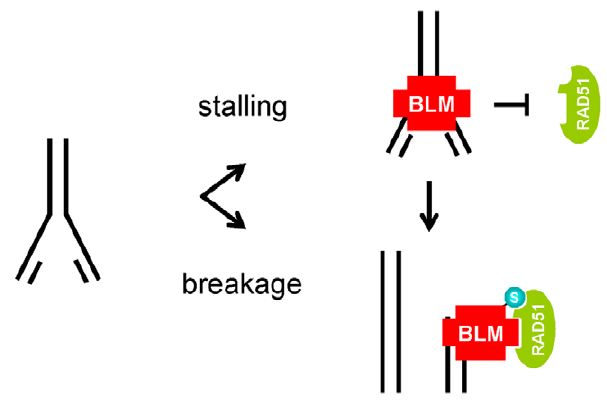
Figure 7. BLM SUMOylation regulates BLM and RAD51 function in HR-mediated repair of damaged forks. The model depicts a replication fork that has either stalled or broken. At stalled forks, unSUMOylated BLM inhibits access of RAD51 to the stalled fork. If the fork progresses to a DSB, BLM SUMOylation promotes the recruitment and/or retention of RAD51 to the broken end through noncovalent interactions between SUMOylated BLM and the SUMO binding site on RAD51. S,